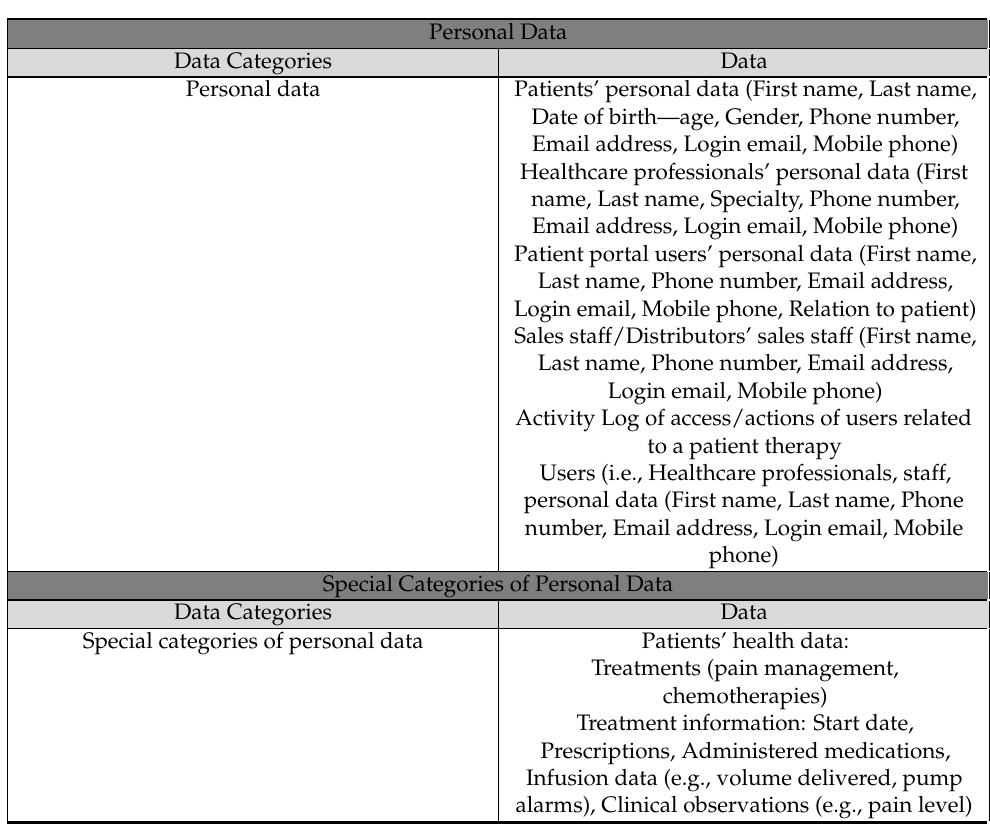
Table 5. Data processed in patients